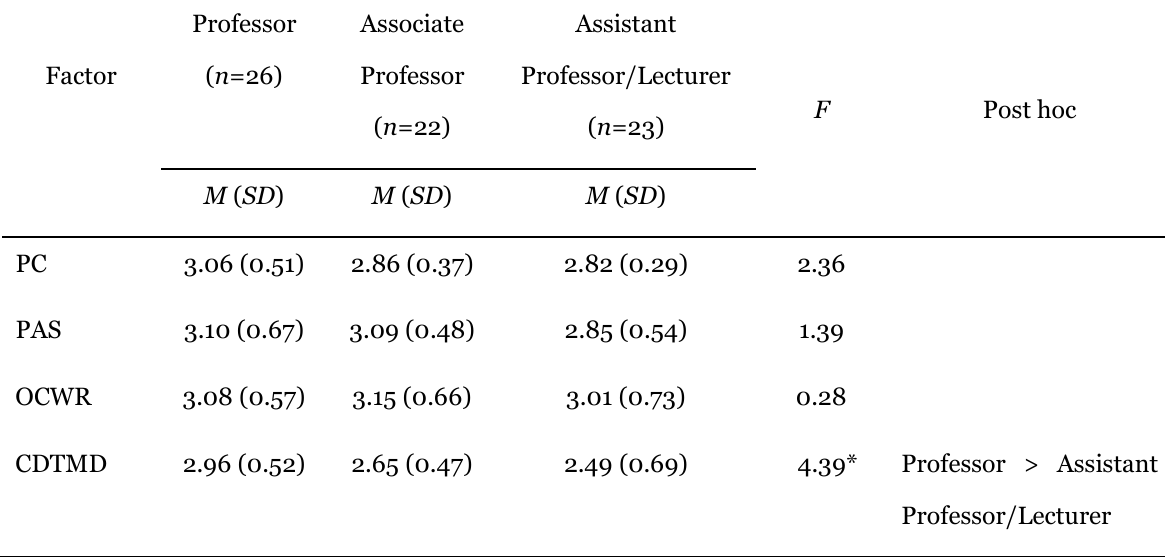
Descriptive Statistics and One-Way ANOVA of Position of OCW-Unexperienced Faculty Relative to TRS- OCW